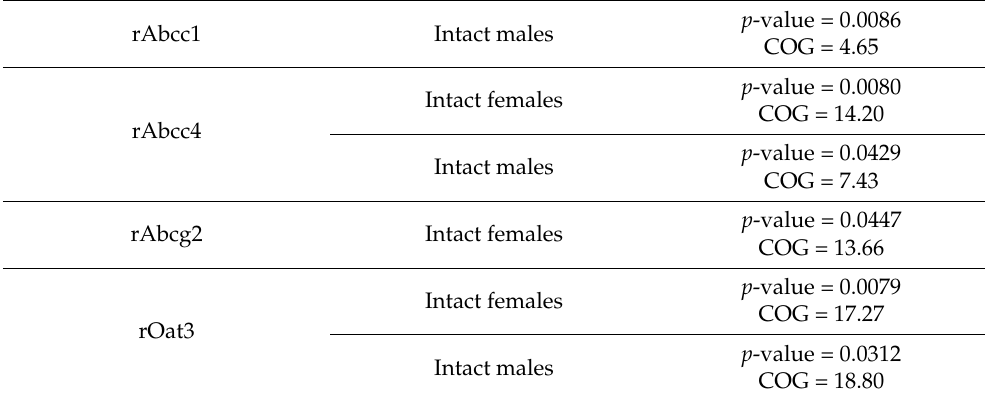
Table 1. Significance ( p -value) and center of gravity (COG) values for rAbcc1, rAbcc4, rAbcg2, and rOat3, as determined by CircWave analysis.